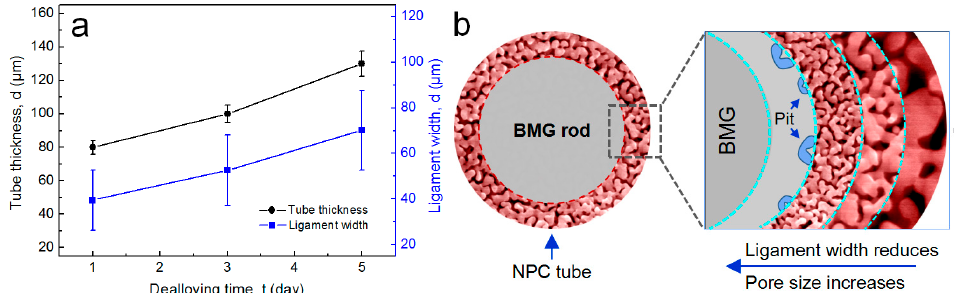
Figure 4. ( a ) Changes in the NPC tube thickness and NPC ligament width with dealloying time; ( b ) Schematic illustration of the hierarchical architectures along the dealloying depth.